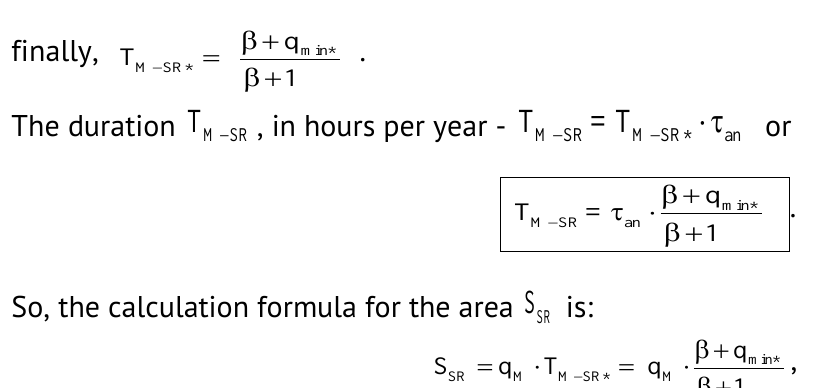
Figure 2. Areas under the SR curve, logistic curve and load duration